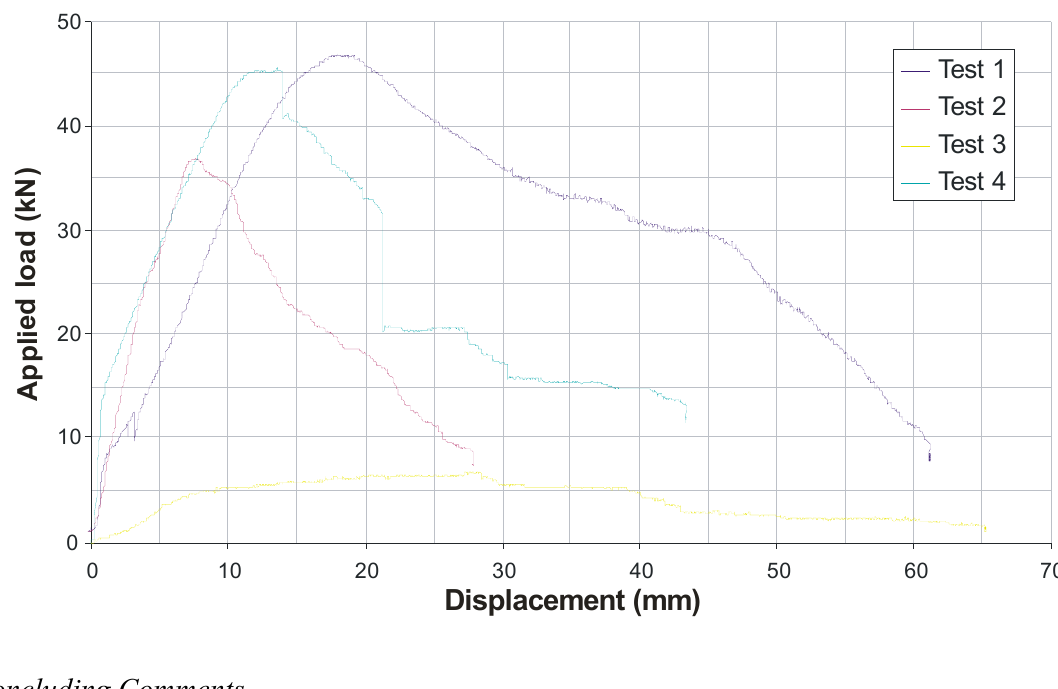
Figure 16. Load-Displacement plots for all four